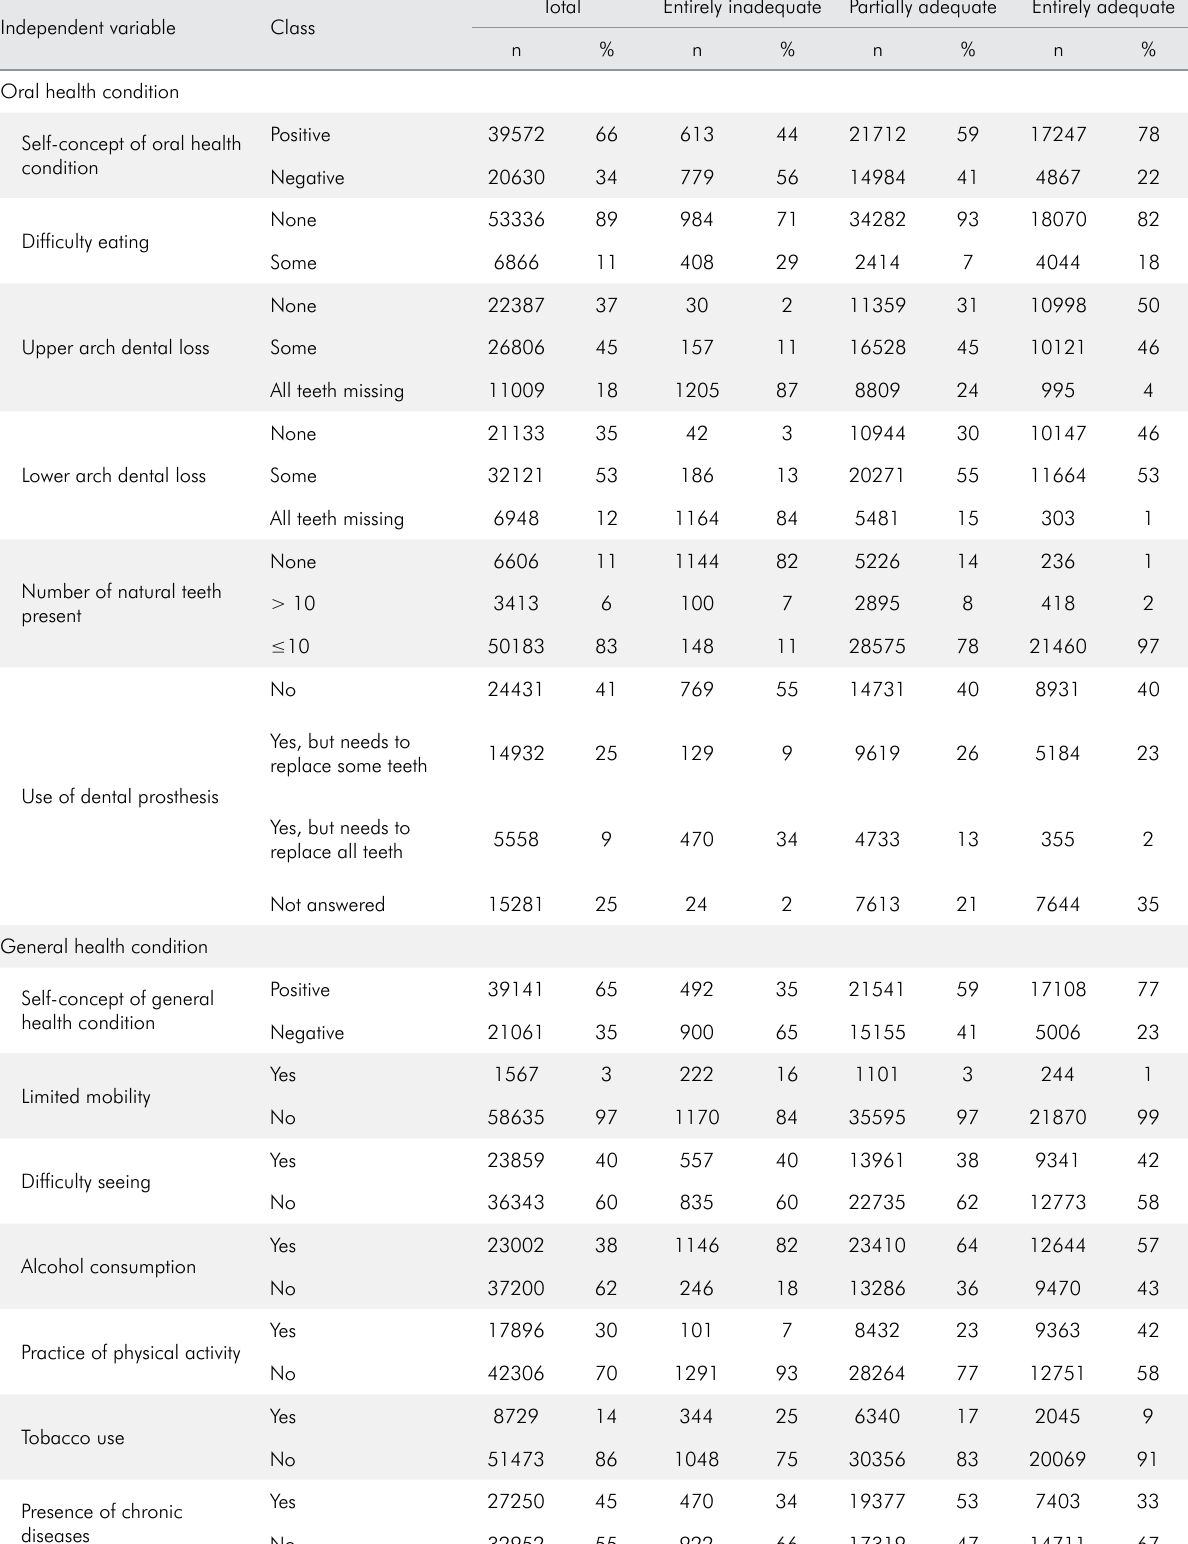
Table 2. Description of the sample, according to overall health conditions. Brazil. 2013. (n = 60202). Independent variable Oral health